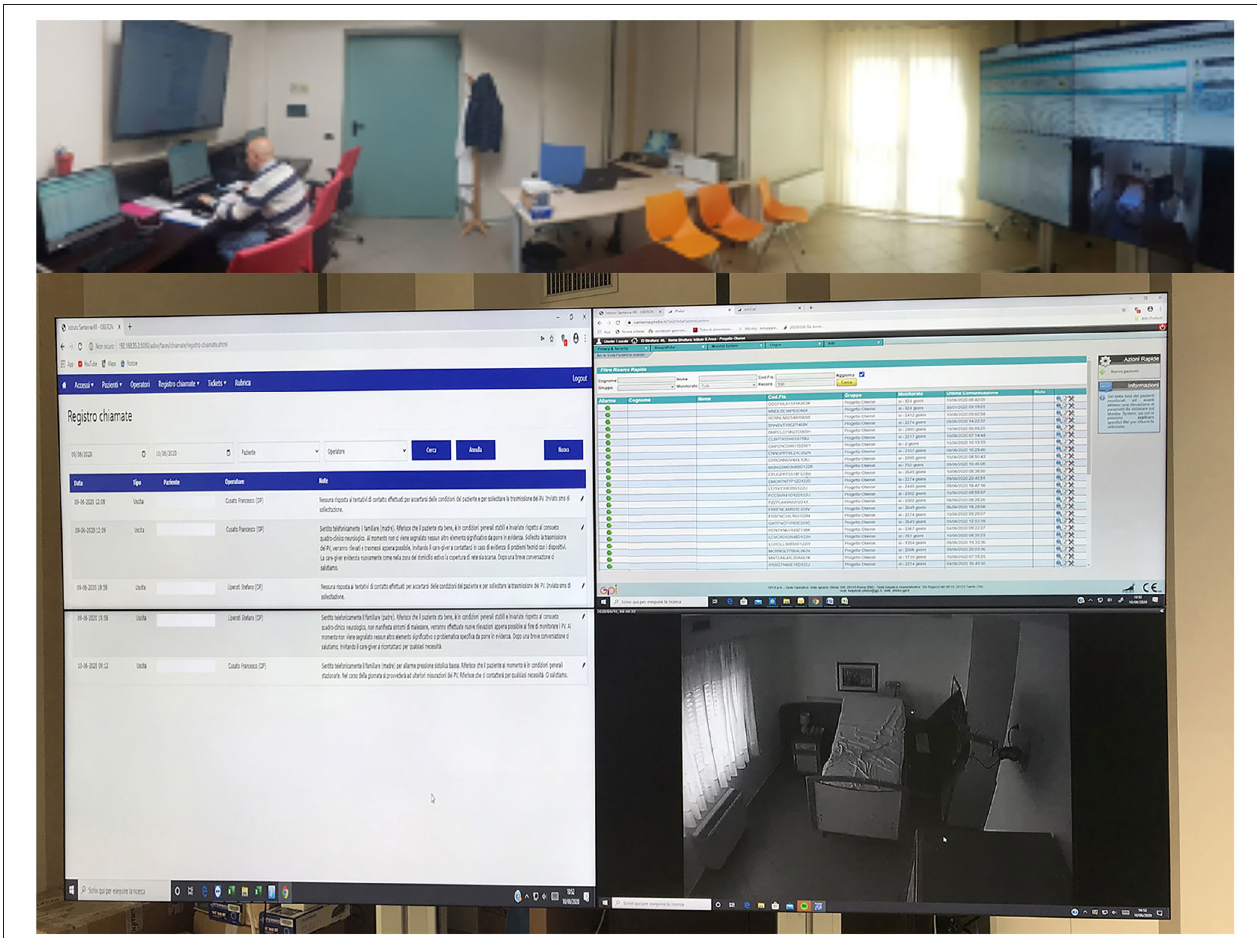
FIGURE 1 | Advanced videoconferencing telehealth system for controlling neurological patients